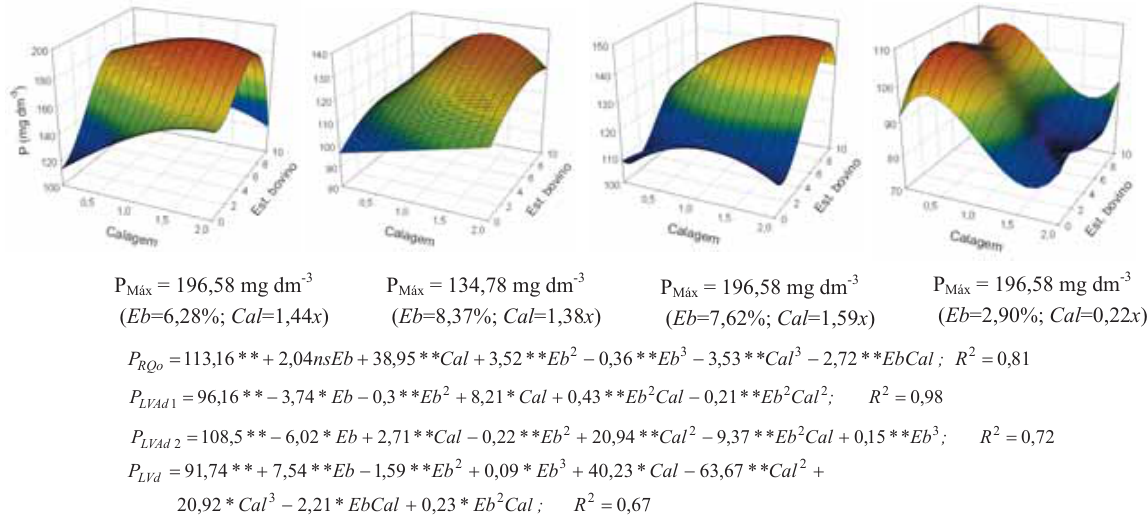
Figura 2. Teores de matéria orgânica (MO) e P Mehlich-1 em função da aplicação de esterco bovino ( Eb - % do volume de solo) e calagem ( Cal - vezes a dose para elevar V = 60 %) nos solos RQo, LVAd-1, LVAd-2 e LVd. **; * e ns: significativo a 1 e 5 % e não-significativo,